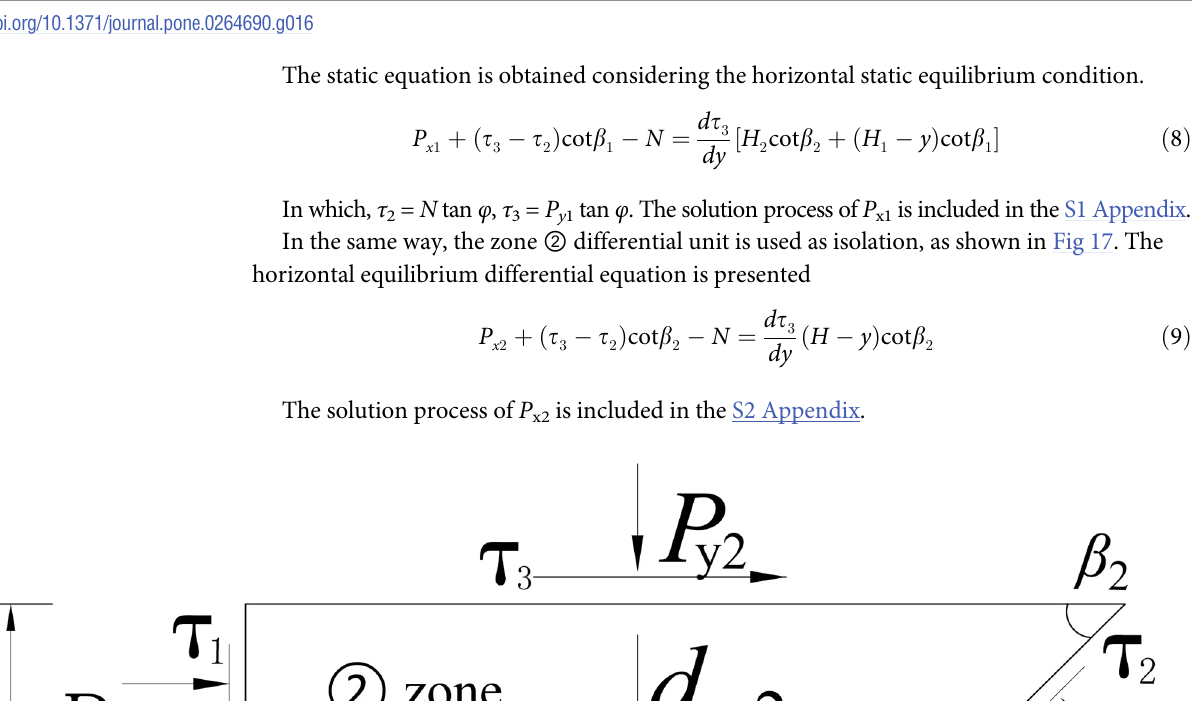
Fig 16. Forces analysis on zone ① .